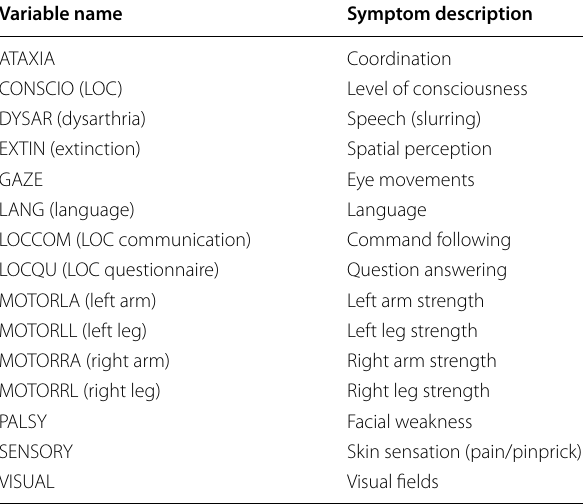
Table 1 NINDS tPA trial data, variable names and